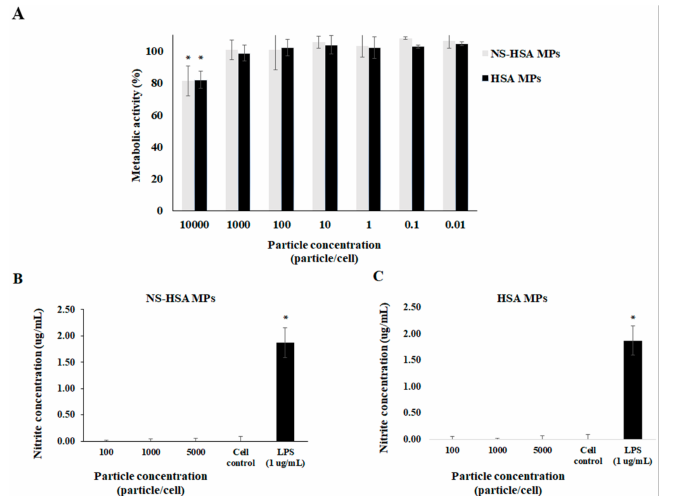
Figure 10. Metabolic activity of RAW264.7 cells after treatment with NS-HSA MPs and HSA MPs ( A ) and stimulation of macrophage to release nitric oxide by NS-HSA MPs ( B ) and HSA MPs ( C ). Data are presented as mean ± SD. * p ≤ 0.05 was determined by t